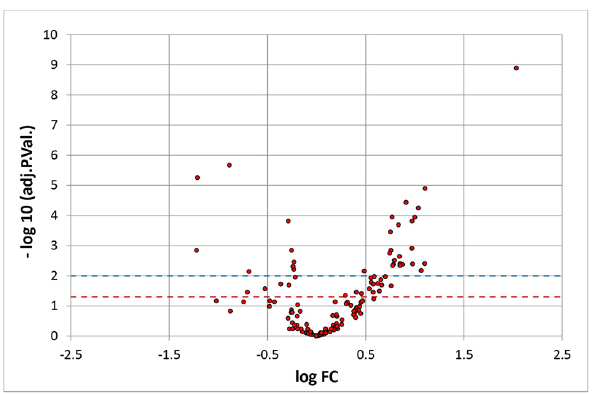
Figure 1: Volcano plot of di ff erentially expressed proteins from samples from TMD patients and a healthy control group, visualizing the fold - change ( x - axis ) and statistical signi fi cance ( y - axis ) . The red line corresponds to p = 0.05 and the blue line to p =